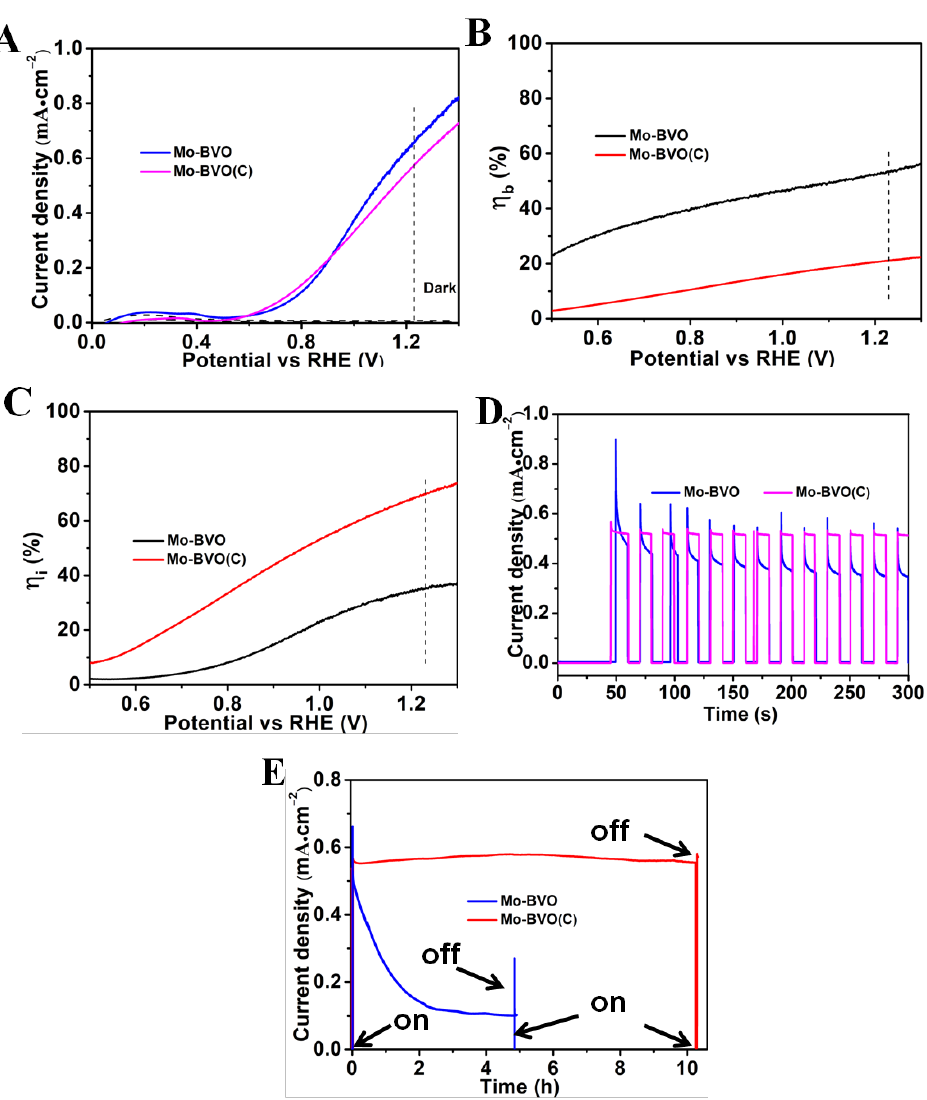
Figure 3. ( A ) Photocurrent density vs. applied potential (J − V) curves measured for the Mo-BVO and Mo-BVO (C) photoanodes, with a scan rate of 20 mV/s under AM 1.5 G illumination in 0.1 M KPi buffer solution. ( B ) The bulk charge separation efficiencies ( η b ) and ( C ) interfacial charge separation efficiencies ( η i ) of Mo-BVO and Mo-BVO (C) as a function of applied bias, respectively. ( D ) Photocurrent vs. time (J − T) measurements performed for the Mo-BVO and Mo-BVO (C) photoanodes with chopped light (AM 1.5 G) at 1.23 V (vs. RHE) in a phosphate buffer (pH = 7) solution. ( E ) J − T curves of the Mo-BVO and the Mo-BVO (C) measured at 1.23V (vs. RHE) for 10 h in a KPi solution (PH =